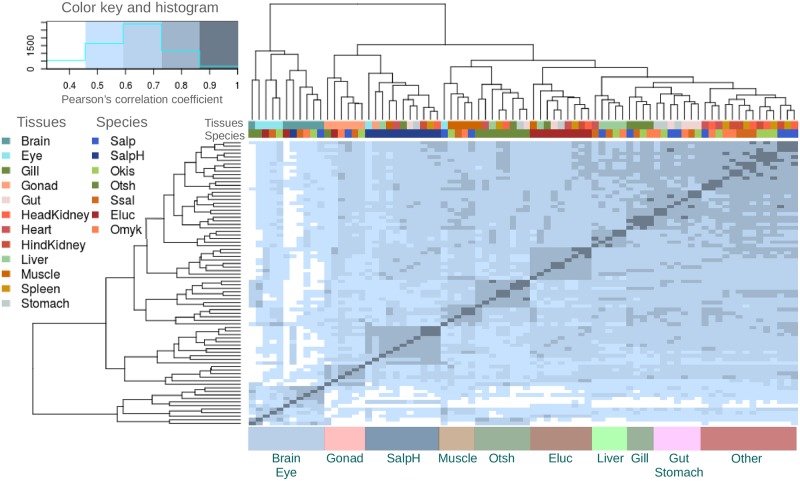
Heatmap of correlation coefficients between species and tissues.Pearson correlation coefficients were calculated between different tissues and species combinations based on log transformed gene expression values (5304 common orthologous or homeologous genes). These values were then used to cluster each tissue-species combination. Both dendrograms represent the same information and each leaf depicts one tissue and species combination. The heatmap shows the correlation coefficient between each combination. The groups at the bottom were manually added to help show how the groups were clustered. (Salp—Arctic charr, SalpH—Arctic charr homeologous gene pair, Okis—coho salmon, Otsh—Chinook salmon, Ssal—Atlantic salmon, Eluc—northern pike, Omyk—rainbow trout).